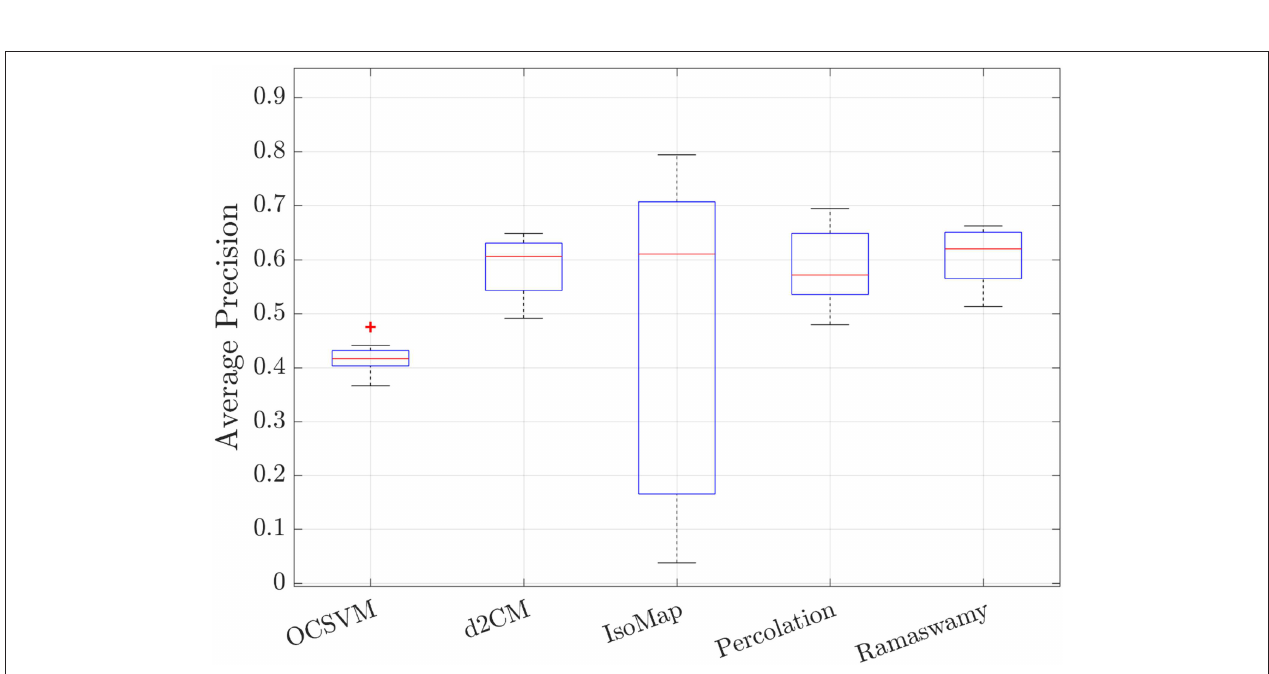
FIGURE 6 | Performance of all the outlier finding methods for the credit card transactions on the test subsets for each amount range.